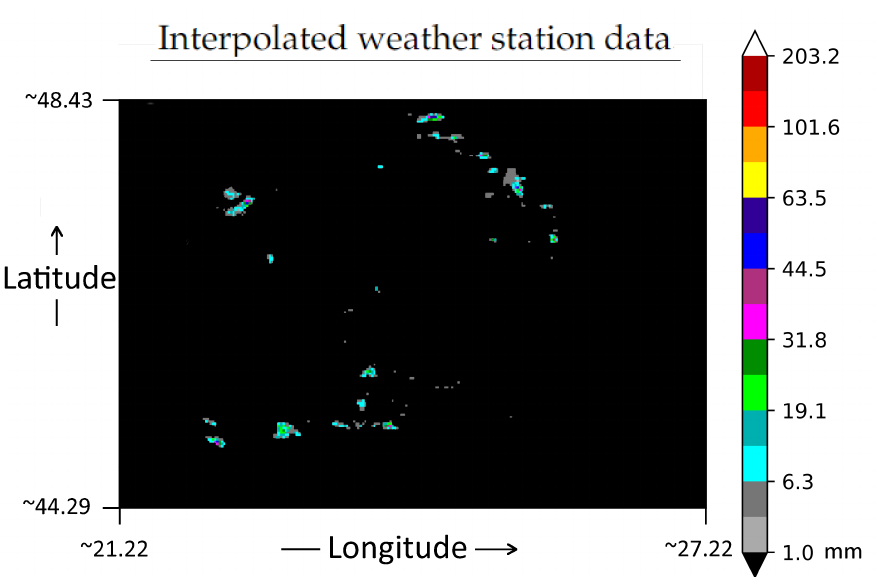
Figure 11. The map depicting interpolated weather station data, representing estimated 1-h rainfall, in